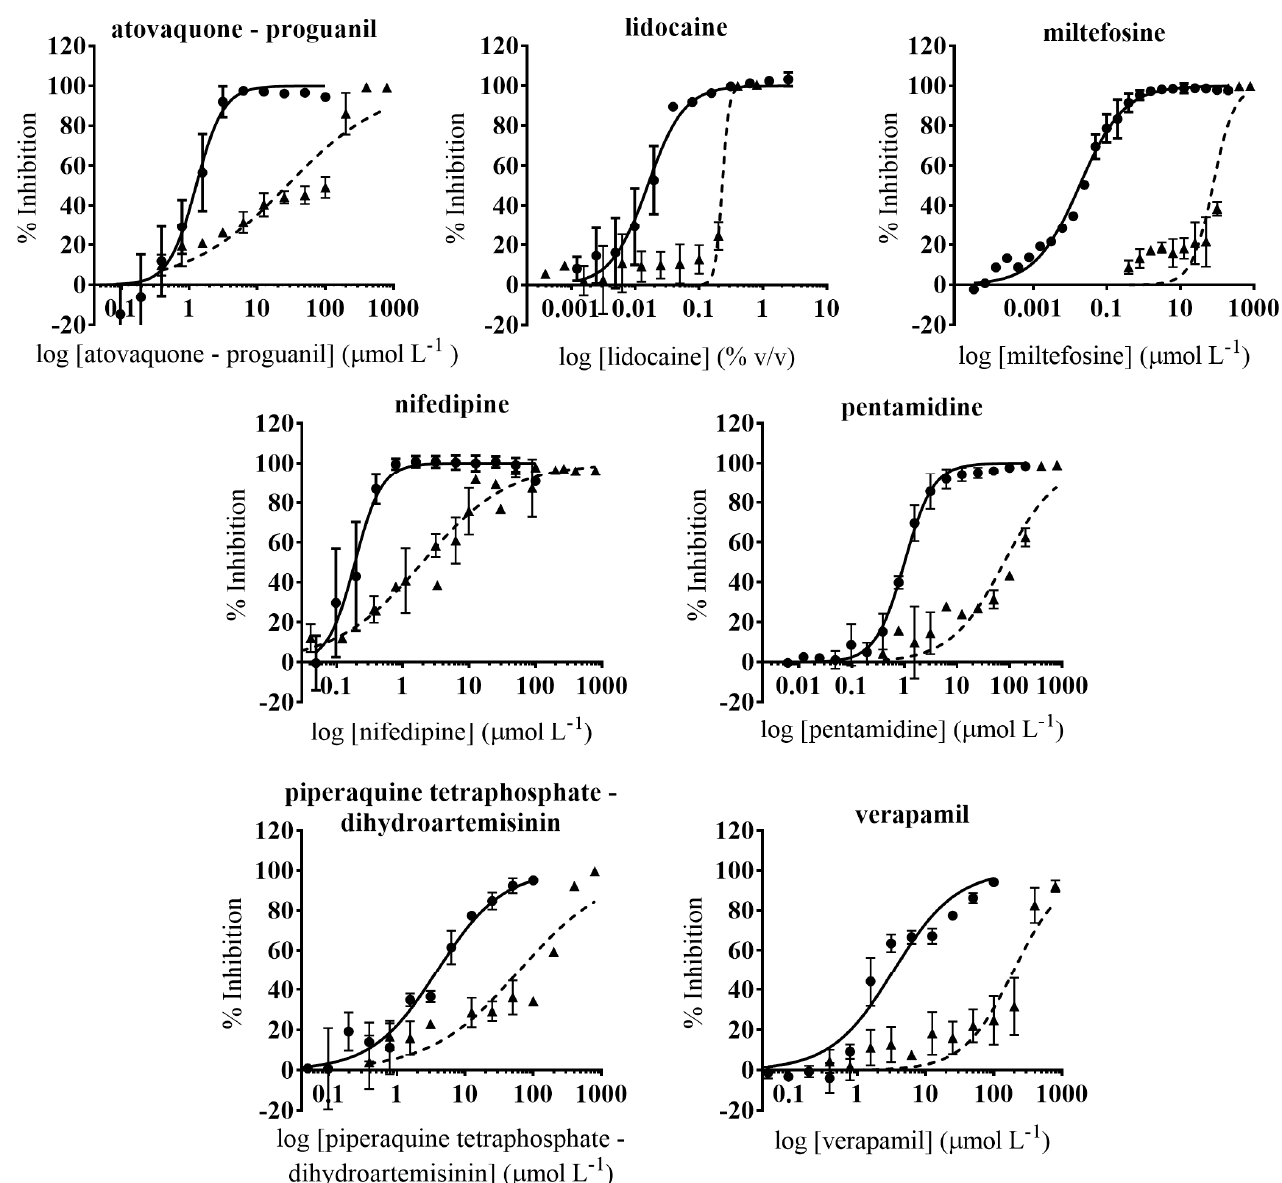
Figure 1. Dose-response curves of anti- T. cruzi and Vero cell toxicity assays of the seven drugs that showed an anti-parasitic activity with IC 50 values < 4 µ mol L − 1 . Anti- T. cruzi assay data are represented by circles and straight lines, while Vero cells toxicity data are represented by triangles and dashed lines. Graphs represent mean values and SD of at least three independent replicas.